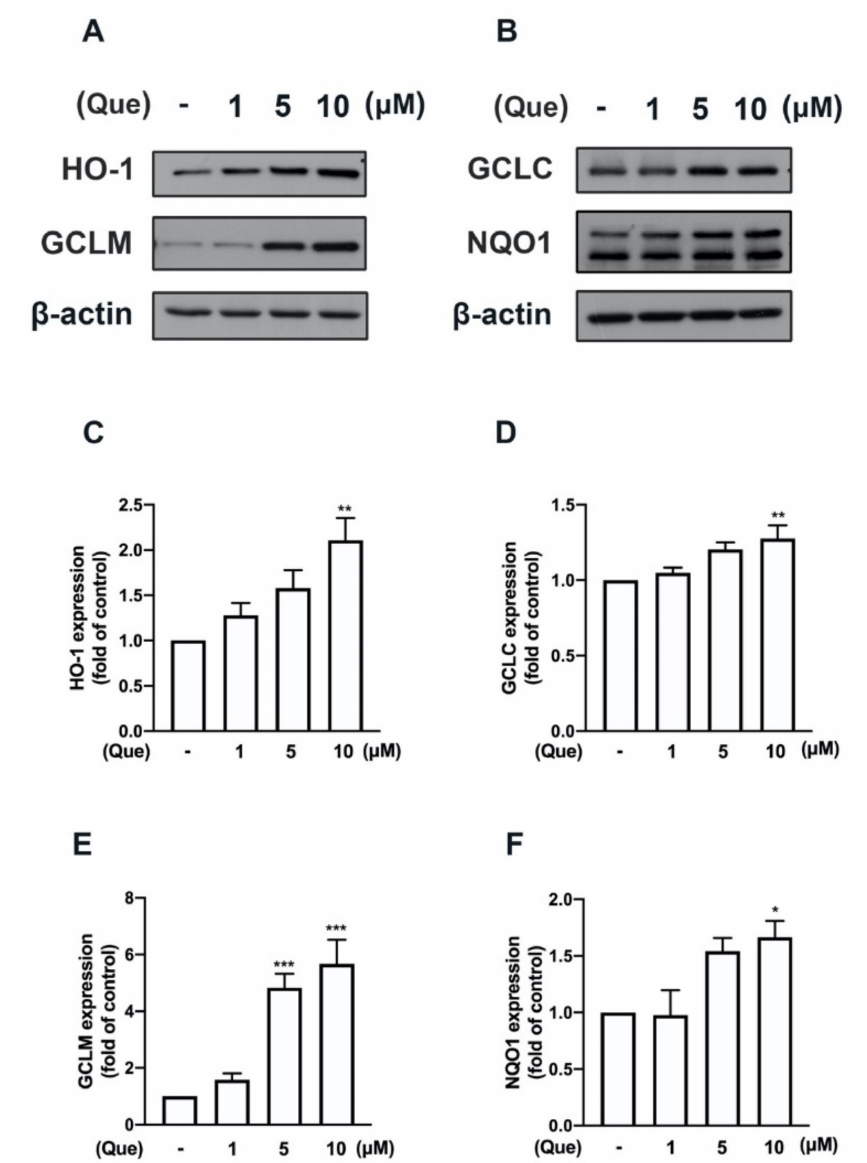
Figure 10. Quercetin promotes the expression of endogenous antioxidants in microglial cells. IMG cells were stimulated with various concentrations of quercetin (1, 5, or 10 µ M) for 24 h. HO-1, GCLC, GCLM, and NQO1 protein levels were determined by western blotting analysis ( A , B ). The quantitative results of HO-1 ( C ), GCLC ( D ), GCLM ( E ), and NQO1 ( F ) were determined using ImageJ software. Each bar represents the mean ± SEM ( n = 3). Note: *** p < 0.001, ** p < 0.01, * p < 0.05 compared with the control